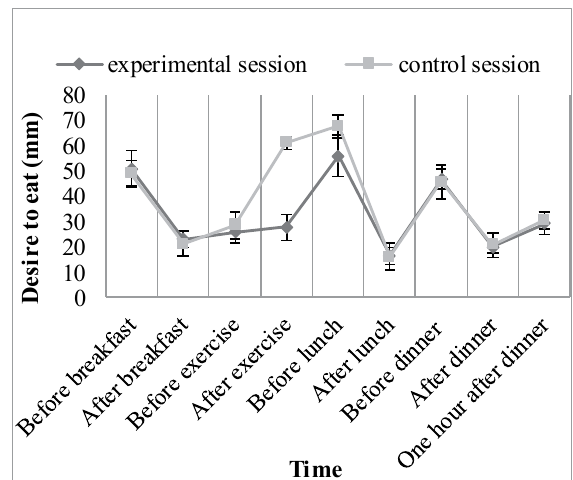
Figure 5 . Rating of desire to eat in the control and experimental session. Values are mean±SD (n=10).